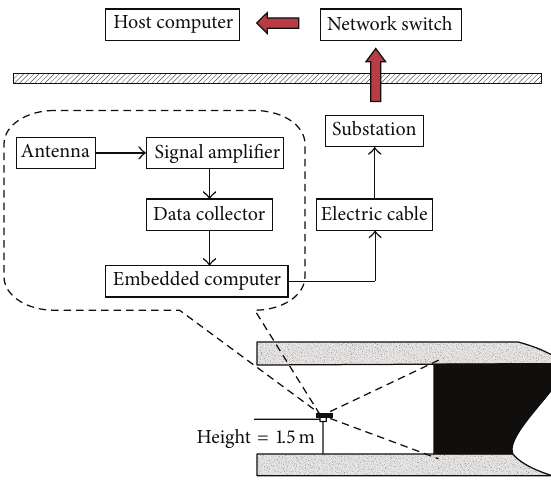
Figure 8: The field test TMVD system diagram.